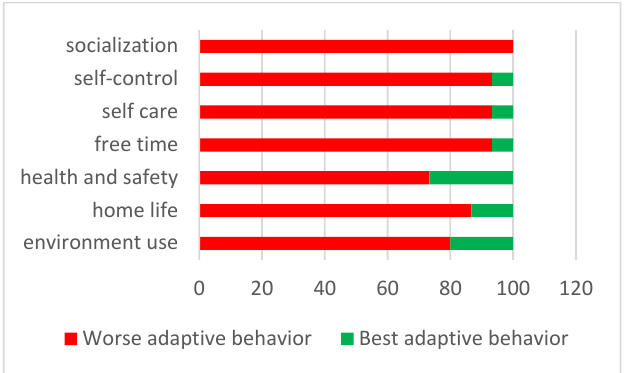
Figure 4. Placement in the worst or best adaptive behavior in ABAS-2 scores in the clinic group. Only secondarily, a series of two paired samples Wicoxon test were run to analyze whether there was a significant difference in each adaptive behavior scale along the be- longing on clinic or control group. Differences were found for the General Adaptive Com- posite GAC (Z = − 2.55; p = 0.01), Conceptual Composite CC (Z = − 2.13; p = 0.3), Social Composite SC (Z = − 3.11; p = 0.002) and Practical Composite PC (Z = − 2.36; p = 0.02). The clinic group members had significantly lower averages in GAC (M = 60.43; SD = 12.92) than the second group (M = 74.12; SD = 10.58), in CC (M = 55.22; SD = 5.33 versus M = 61.17; SD = 3.56), in SC (M = 65.13; SD = 11.03 versus M = 83.38; SD = 14.88) and in PC (M = 69.33; SD = 20.22 versus M = 87.25; SD = 12.67). 3.4. The High Parental Stress Experienced during the Lockdown Influenced the Emotional and Behavioral Difficulties when Children Experienced the Return to School and to Everyday Life since September 2020 For the Asperger group, a significant correlation was found between parental depres- sion scores during lockdown and children ’ s anxiety subscale scores related to school re- turn since September 2020 (r(13) = 0.56, p = 0.029). For the neurotypical group, a significant correlation was found between the questionnaire scores on the well-being perceived by their parents during quarantine and the scores related to the perception of life that ado- lescents themselves attribute to the “ current moment ” (r(13) = − 0.57, p = 0.02). 4. Discussion What motivated this study was to try to give a greater voice to children and young people with Asperger syndrome (clinical population still little investigated from the point of view of the literature) with regard to their perceptions and evaluations at a retrospec- tive level during the lockdown and their understanding of the anti-COVID rules. Above all, we wanted to investigate the long-term consequences associated with the resumption of everyday life. Furthermore, taking into consideration the parental point of view and comparing it with those of neurotypical children, the secondary aim would be, through a comparative analysis, to prepare ad hoc guidelines for parents and teachers on how to support and help children with Asperger ’ s, the behaviors to follow and the management of safe and secure behaviors in schools and in relationships with others; but also to give feedback to the operators of their centers of afference. The psychologists of the center had underlined a notable characteristic of Asperger ’s children, namely the diligent respect of rules and duties after they had been explained in a language they could understand. These explanations were given not only by the psy- chologists and parents but also by the school, which assumed a fundamental role in the prompt provision of various information on COVID-19 and in the support of adolescents. This feature allowed hypothesizing an adequate knowledge and constant implementation of the anti-COVID rules confirmed by the results of the ad hoc questionnaire on perceived risk. In fact, the data confirm a good understanding and application of the regulations by